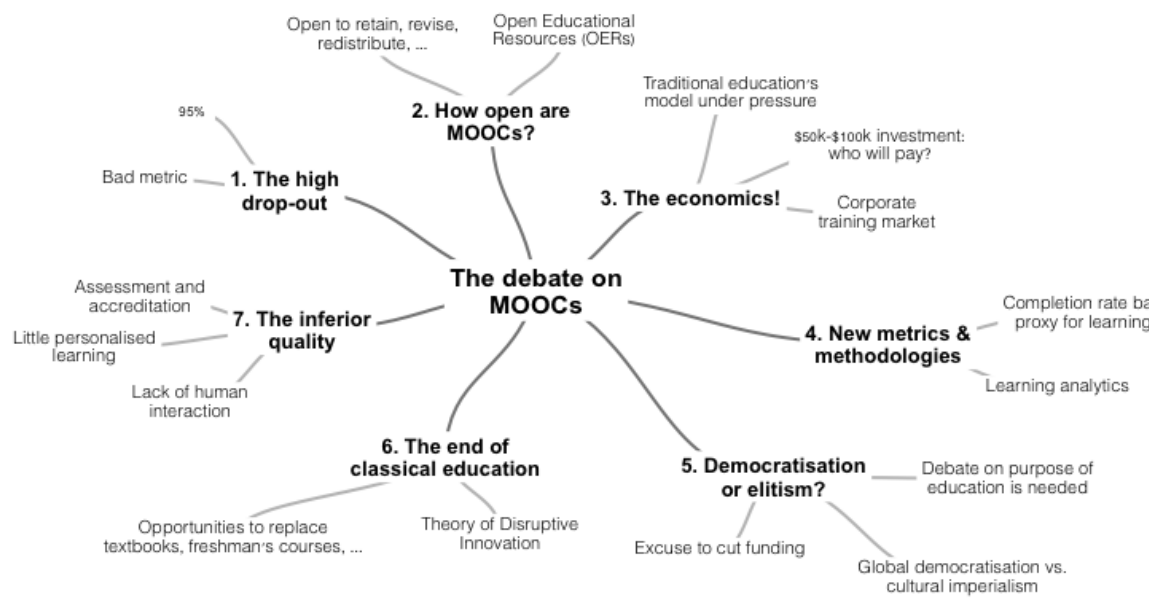
Figure 2 . An overview of the running debate on MOOCs in the blogosphere and specialized press. Topics include economical, technical, ped LISTNUM agogical as well as political